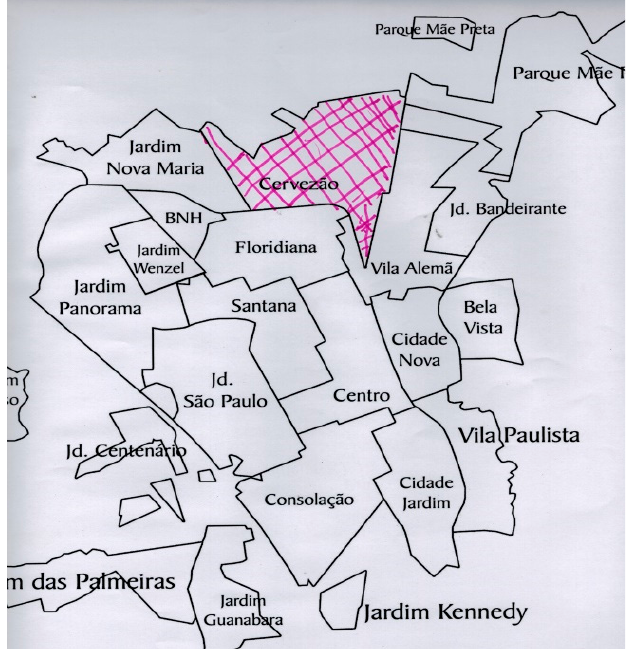
Figure 1. Product of “Workshop 2—Importance clothesline”. The colored part is the place where the person circulates in the city.